Question: Looking at the figure, what chart type is it?
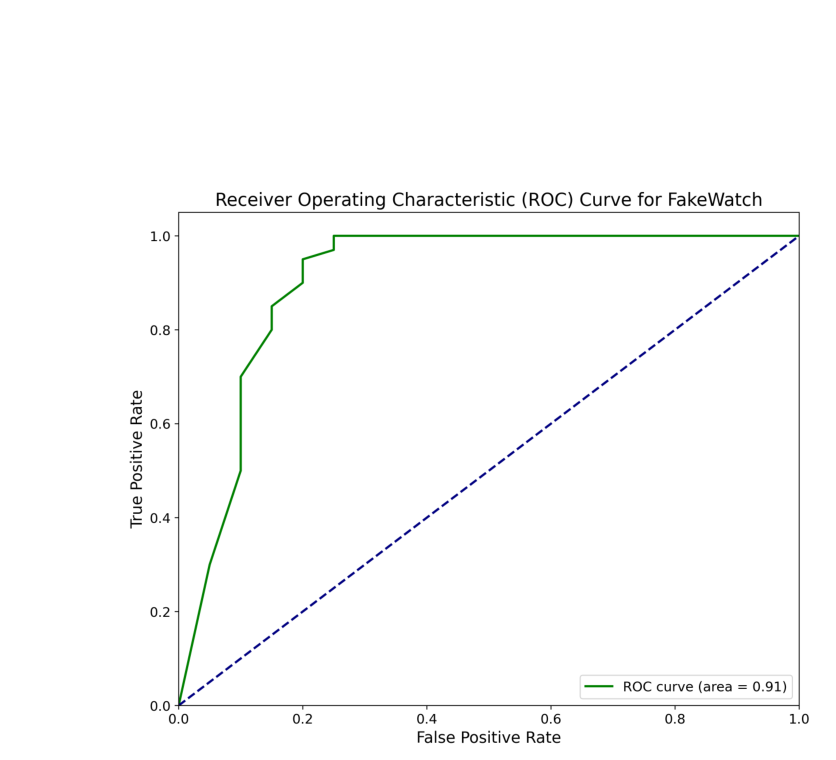
Answer: line